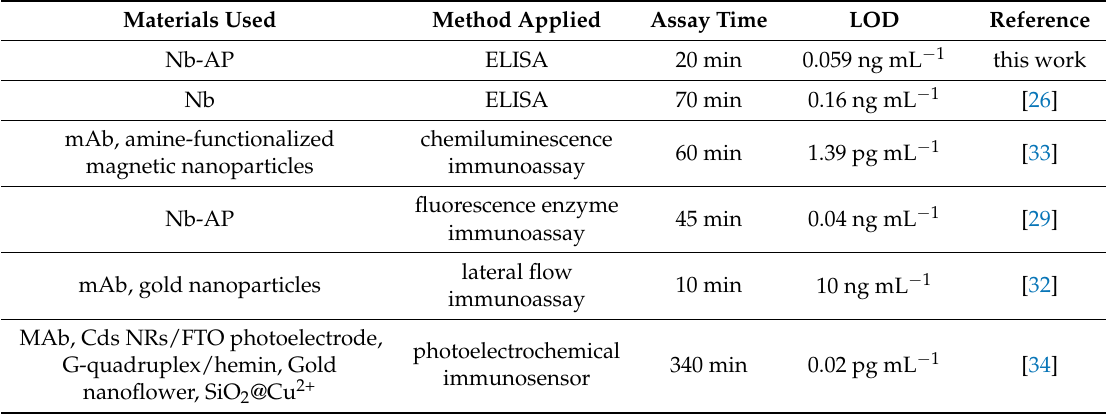
Table 1. Overview of recently reported immunoassays for ochratoxin A.